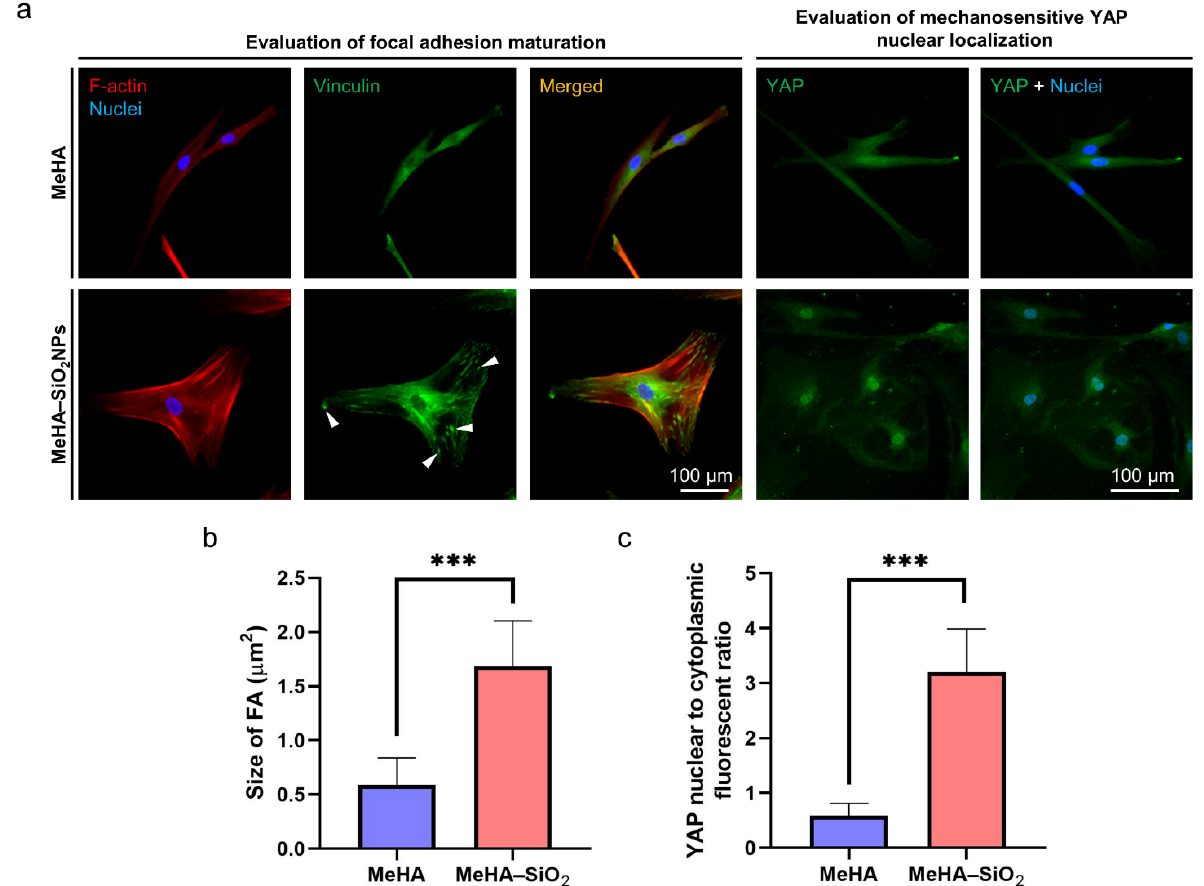
Figure 4. Evaluation of mechanotransduced events of hMSCs cultured on the soft nanocomposite hydrogel. ( a ) Immunofluorescent staining of focal adhesion (FA) marker, vinculin (green at the left panel) and mechanosensitive marker, yes-associated protein (YAP, green at the right panel) of cells cultured on the hydrogels for 24 h. The error bars represent the s.e.m. Statistical analysis of ( b ) size of FA and ( c ) YAP nuclear localization ratio. Significance difference p -value: *** p < 0.001 (one-way ANOVA).